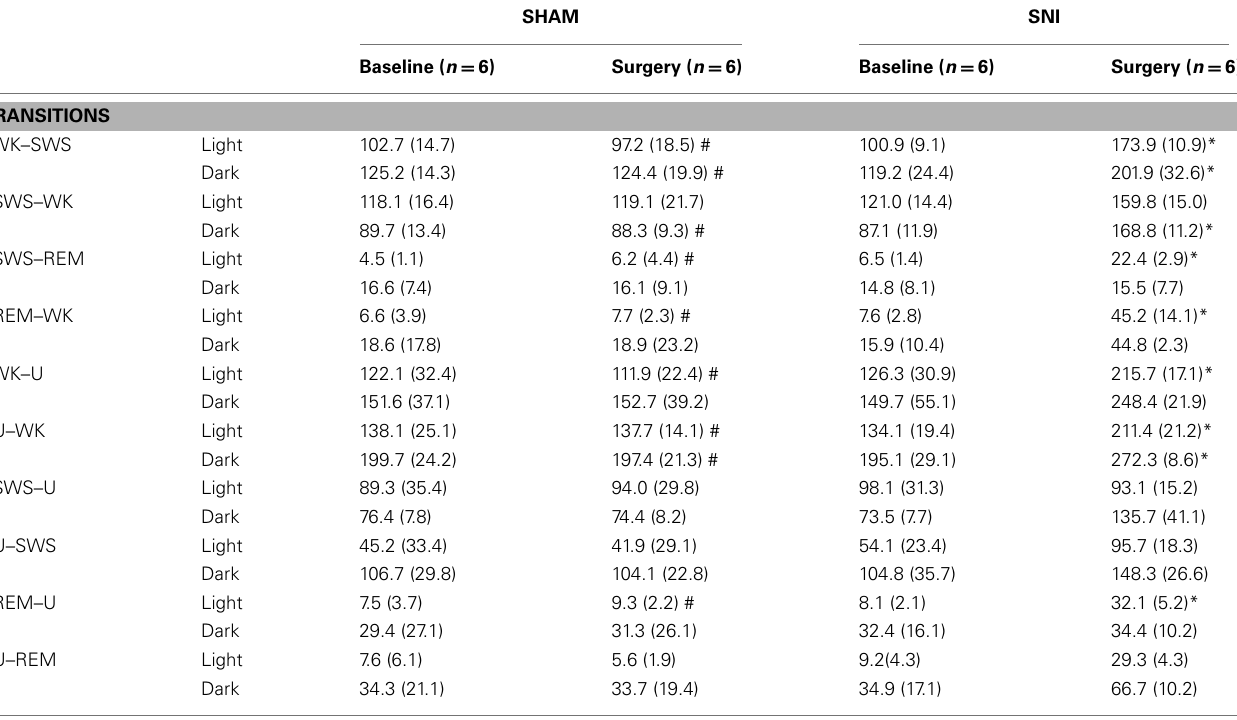
Table 2 |The number of transitions from the different sleep states to wakefulness are shown for the light and dark phases (expressed as mean value per period of